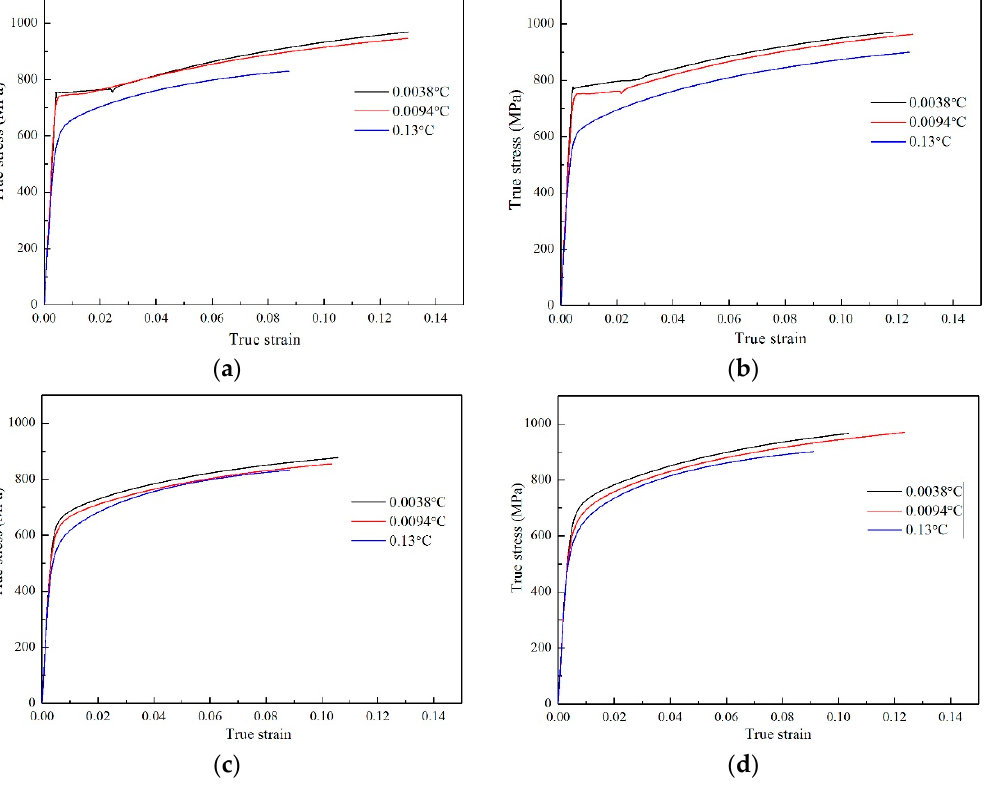
Figure 10. Tensile curves of the tested steels at the different cooling rates: ( a ) S1 steel; ( b ) S2 steel; ( c ) S3 steel; ( d ) S4 steel.